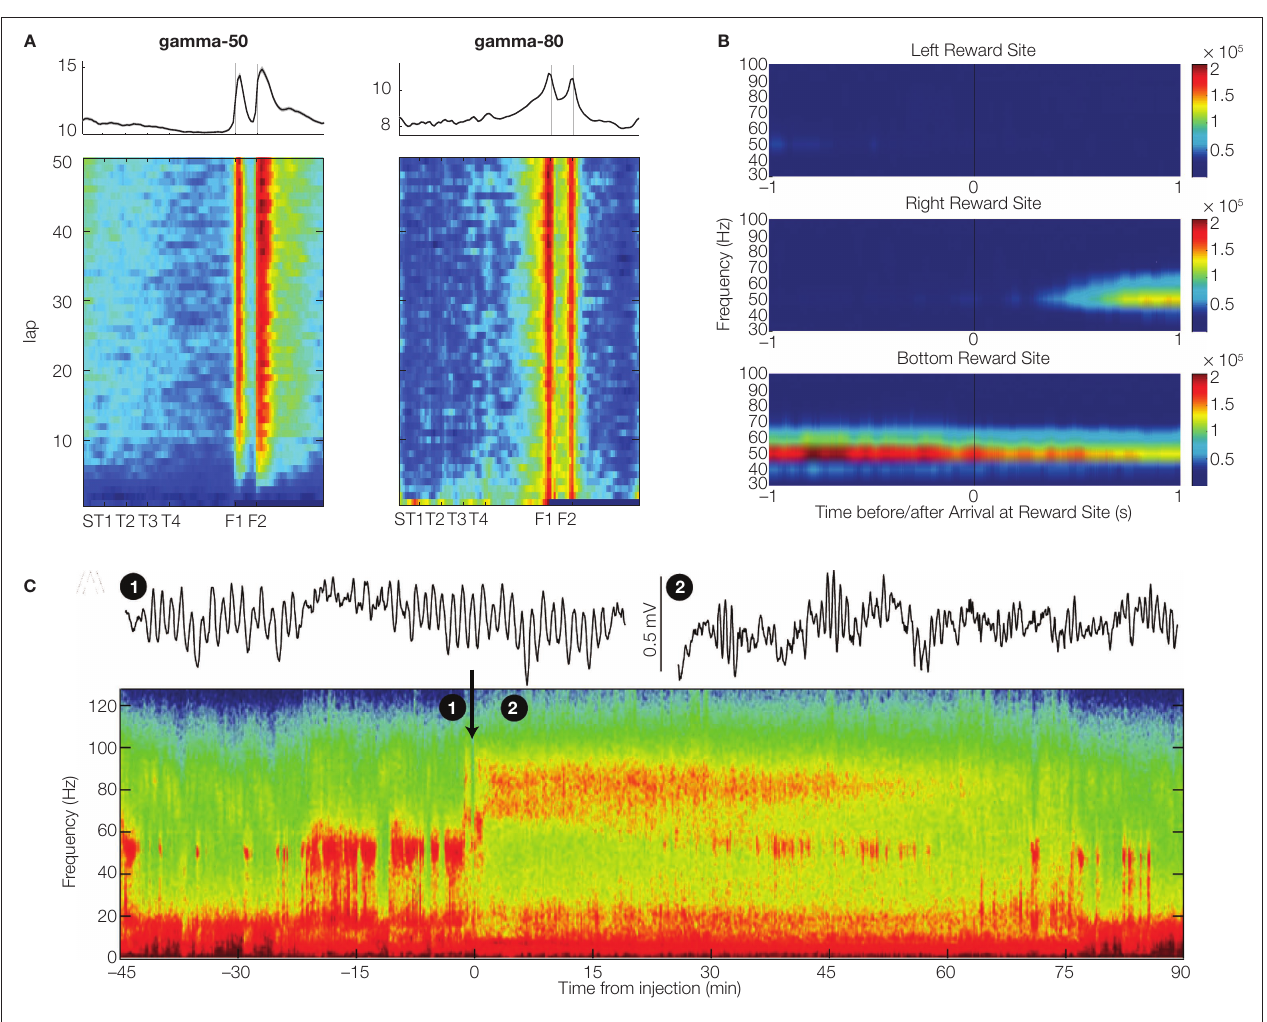
differentiated between distinct reward sites (with different appetitive rewards) on a triangular track in Kalenscher et al. (2010). This particular LFP trace had almost no gamma power at the left reward site, but strong power at the bottom site. (C) Systemic application of the dopaminergic agonist apomorphine (at time 0; black arrow) caused a switch from gamma-50 to gamma-80. Example traces (1) and (2) were taken from the times indicated in the spectrogram, before and after drug administration respectively. Data from Berke